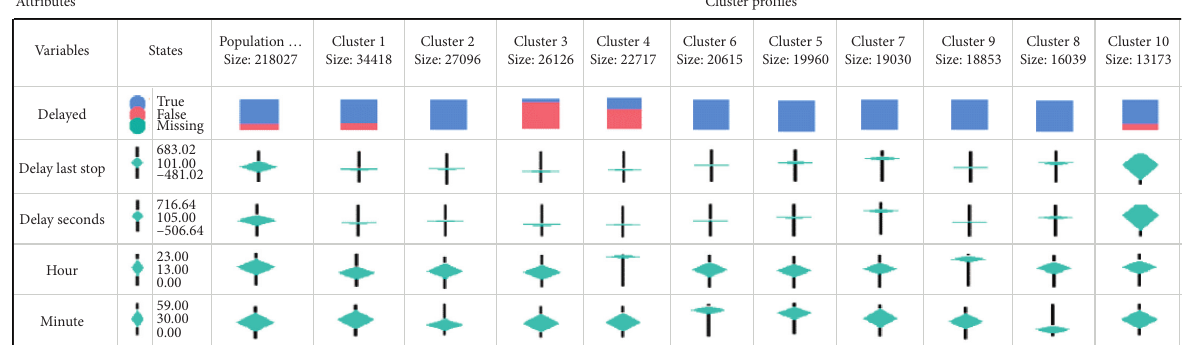
Figure 5: Profiles of the 10 clusters generated by EM showing if they are associated with delay or not, as well as the attributes that are the most predominant for each of them.